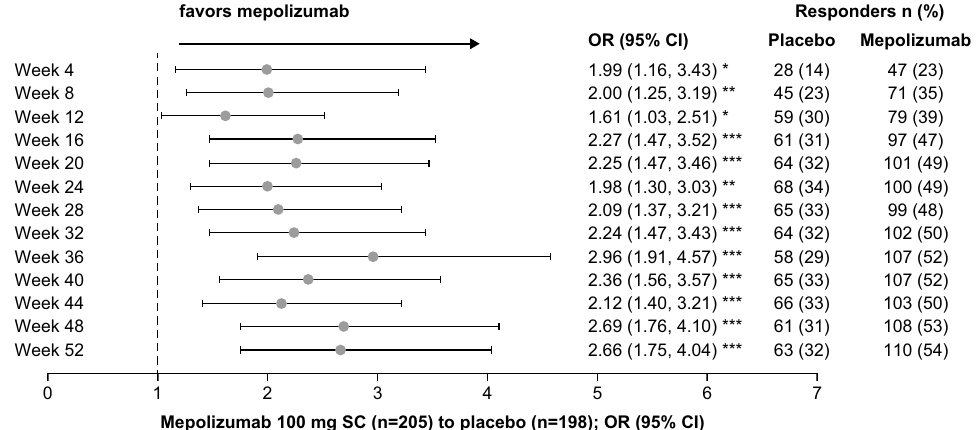
Fig. 7 Probability of patients reporting OR (mepolizumab vs placebo) of percentage of patients reporting greater efficacy of mepolizumab. CI Confidence interval, OR Odds ratio, SC subcutaneous, SNOT-22 Sino-nasal outcome